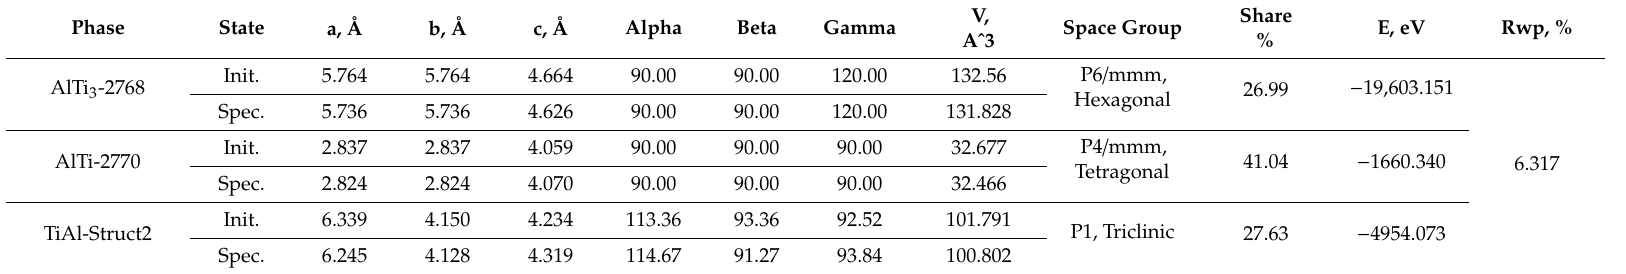
Table 2. Structural parameters of the lattices and the share of phases, and the convergence criterion of the TAY alloy.